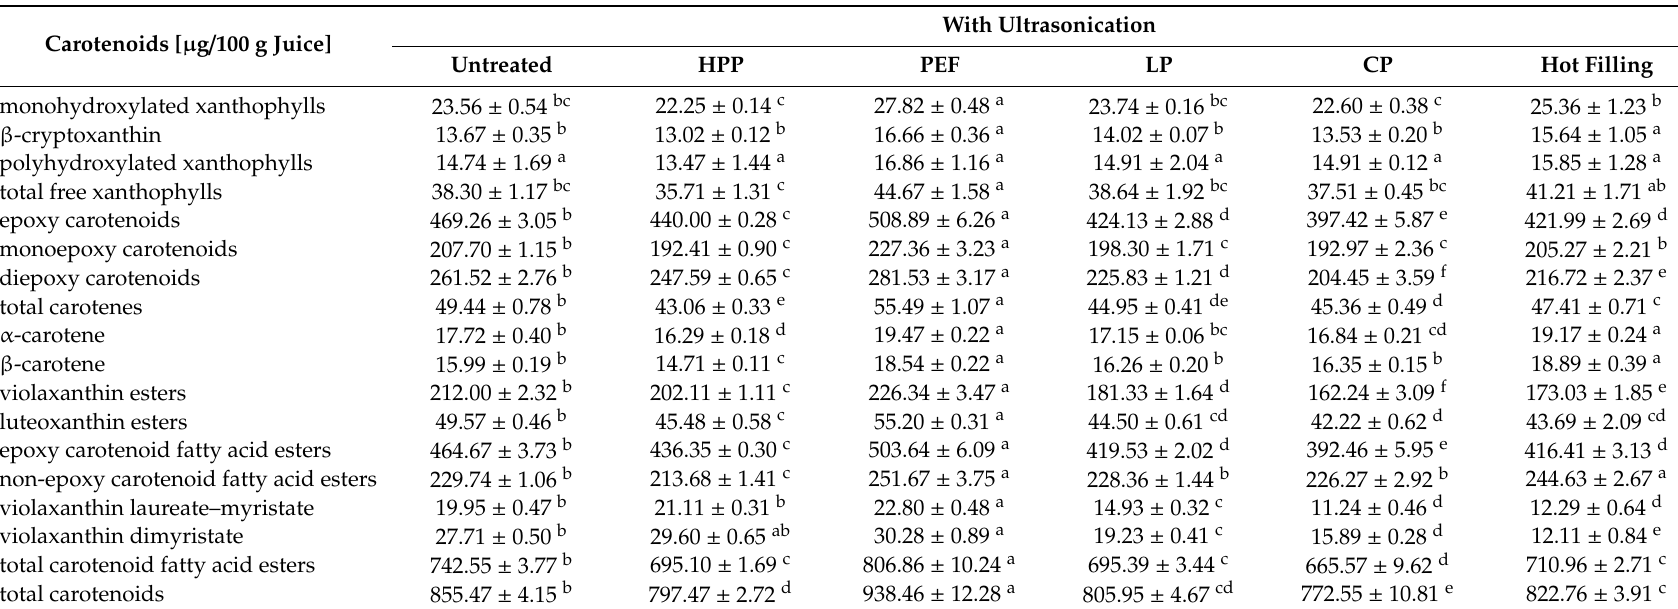
Table 5. Carotenoid concentrations in ultrasonicated orange juices. Di ff erent letters indicate significant di ff erences ( p ≤ 0.05). Values are means ± standard deviation ( n =